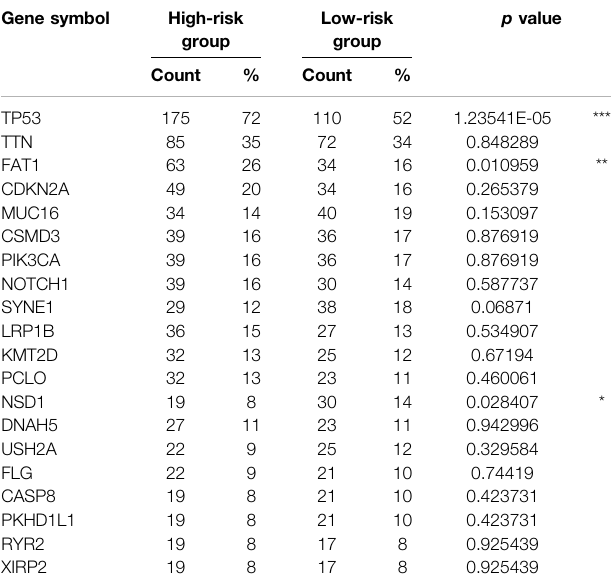
TABLE 3 | Differences in mutated genes between high and low risk